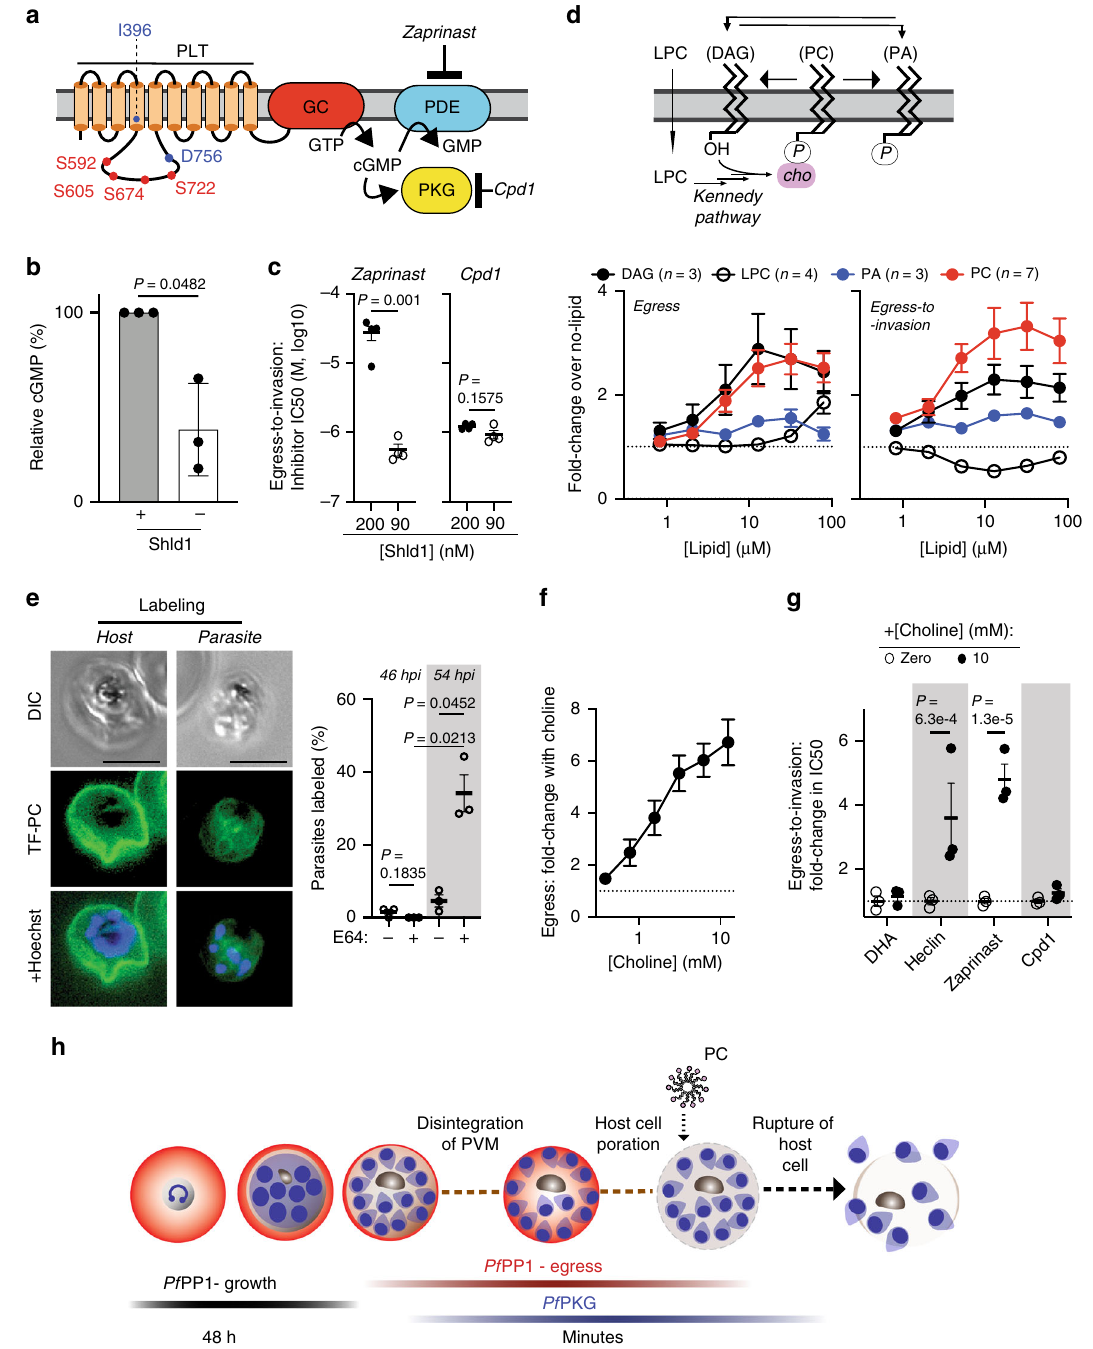
(PDE) inhibitor 31,51 (Fig. 4a). The susceptibility of egress-to- invasion of Pf PP1-DD parasites to zaprinast becomes sharply increased with knockdown: IC50 values drop by as much as ~400- fold to submicromolar levels (Fig. 4c; Supplementary Figs. 2d and 6b). We found that zaprinast inhibition is mitigated by the Pf PKG inhibitor Compound-1 (Cpd1) 45 (Supplementary Figs. 2d and 6c), consistent with the interpretation that toxicity of the PDE inhibitor requires activation of the well-established downstream effector of cGMP signaling in Plasmodium parasites. In contrast to zaprinast, functional interaction of Pf PP1-DD with Cpd1 is weak, with measurements of egress-to-invasion showing no chemical-genetic interaction (Fig. 4c). Parasite egress is more sensitive to Cpd1 with Pf PP1-DD knockdown, though much less than the shift in